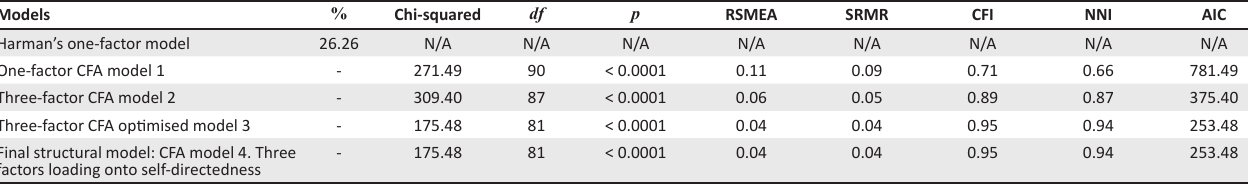
TABLE 2a: Goodness-of-fit indices: Adult Learner Self-Directedness Scale. Models